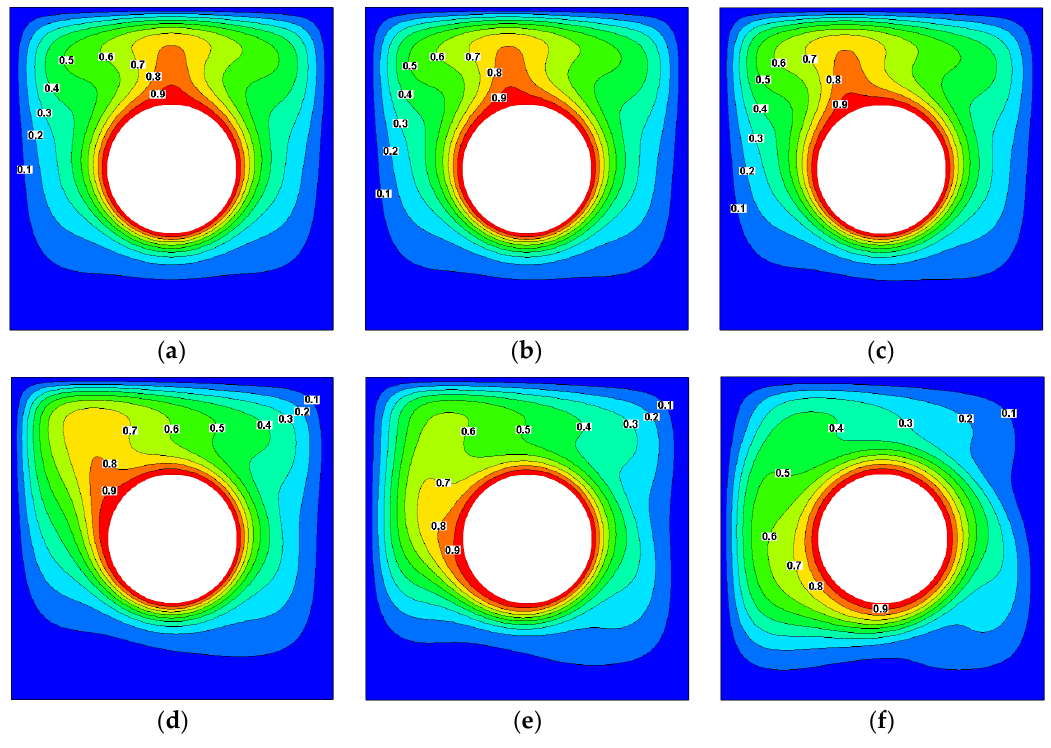
Figure 9. ( a ) N = 0, ( b ) N = 10, ( c ) N = 20, ( d ) N = 50, ( e ) N = 100, ( f ) N = 200. Contours of dimensionless temperature at λ = 0.4, Ha = 40 and Ra = 10 6 .